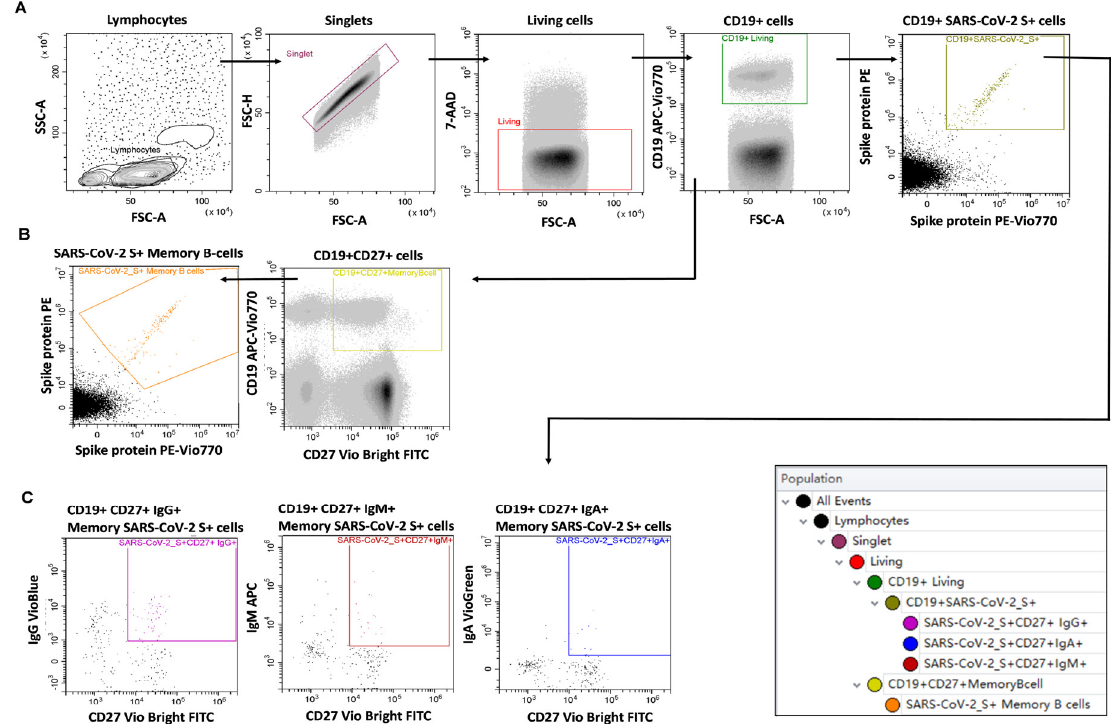
Figure 2. Gating strategy of the immunophenotyping to determine the SARS-CoV-2 S-protein reactive peripheral ( A ) CD19+ B-cells, ( B ) CD19+CD27+ memory B-cells, ( C ) the SARS-CoV-2 S-protein reactive peripheral IgG, IgM, or IgA positive CD19+CD27+ memory B-cells. After the withdrawal of peripheral blood, PBMCs were purified and labeled with a cocktail of antibodies and fluorescently labeled spike (S) protein as described in the 4.5 Materials and Methods section. Reactive cells were acquired and quantified on a flow cytometer. Population hierarchy corresponds to the gating hierarchy on the right. Cell debris and aggregates were excluded by manual gating determining single cells as singlets. To avoid the analysis of the unspecific labeling of dead cells, living cells were gated as negative for the 7-AAD viability dye. The gate of lymphocytes was determined by the CD19 positivity of living singlets. Living singlets of lymphocytes were analyzed